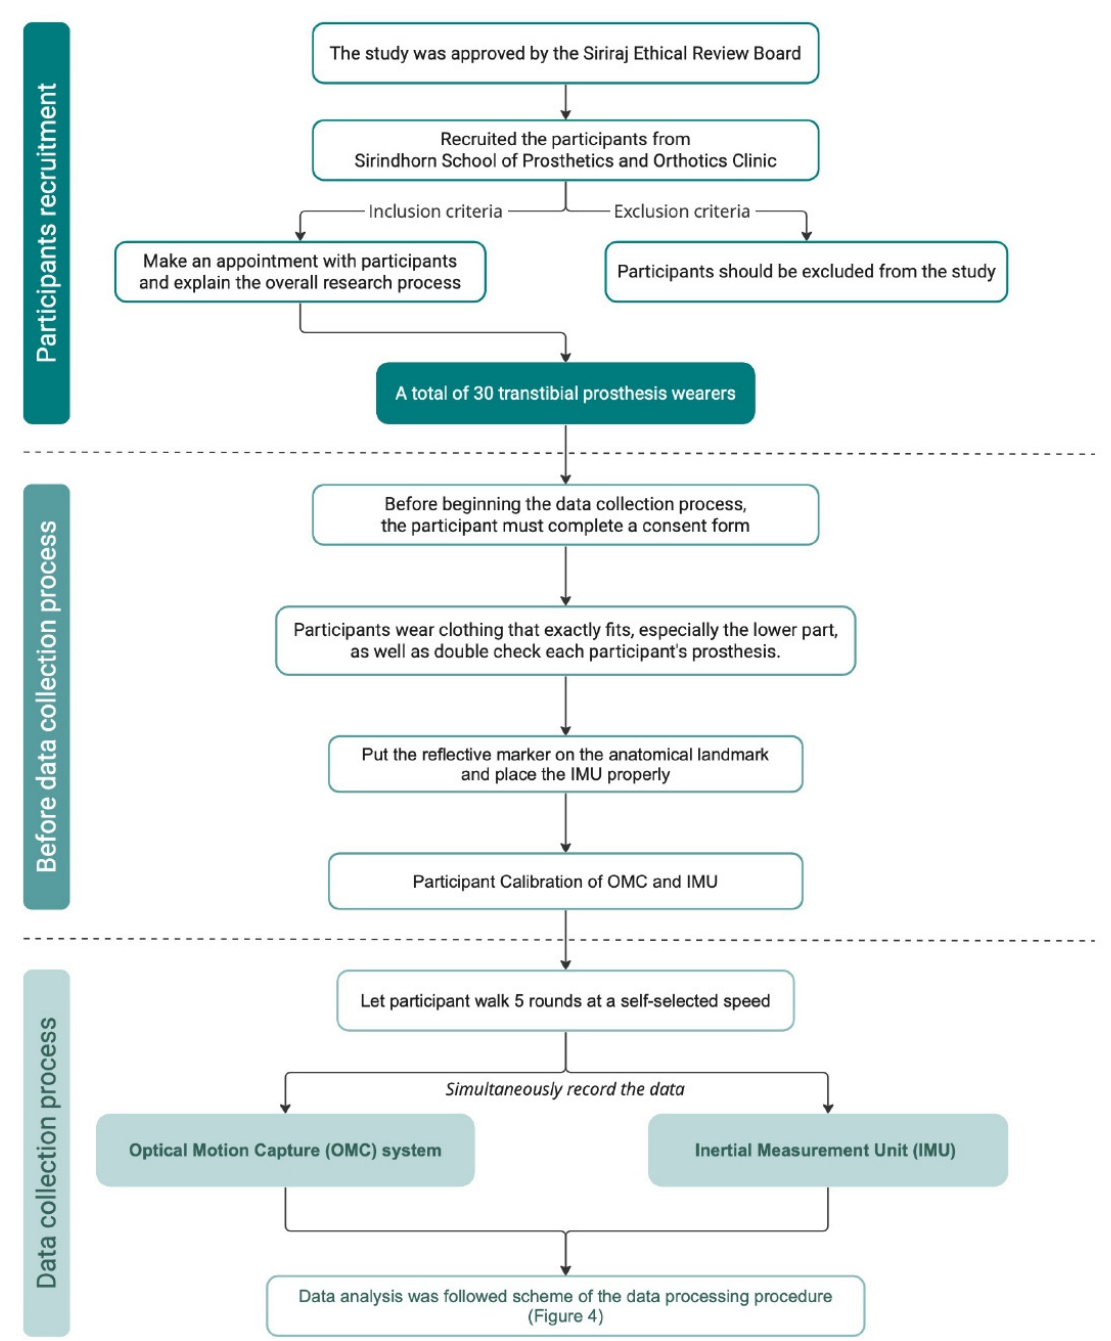
Figure 1. Flow chart showing the experimental design of the